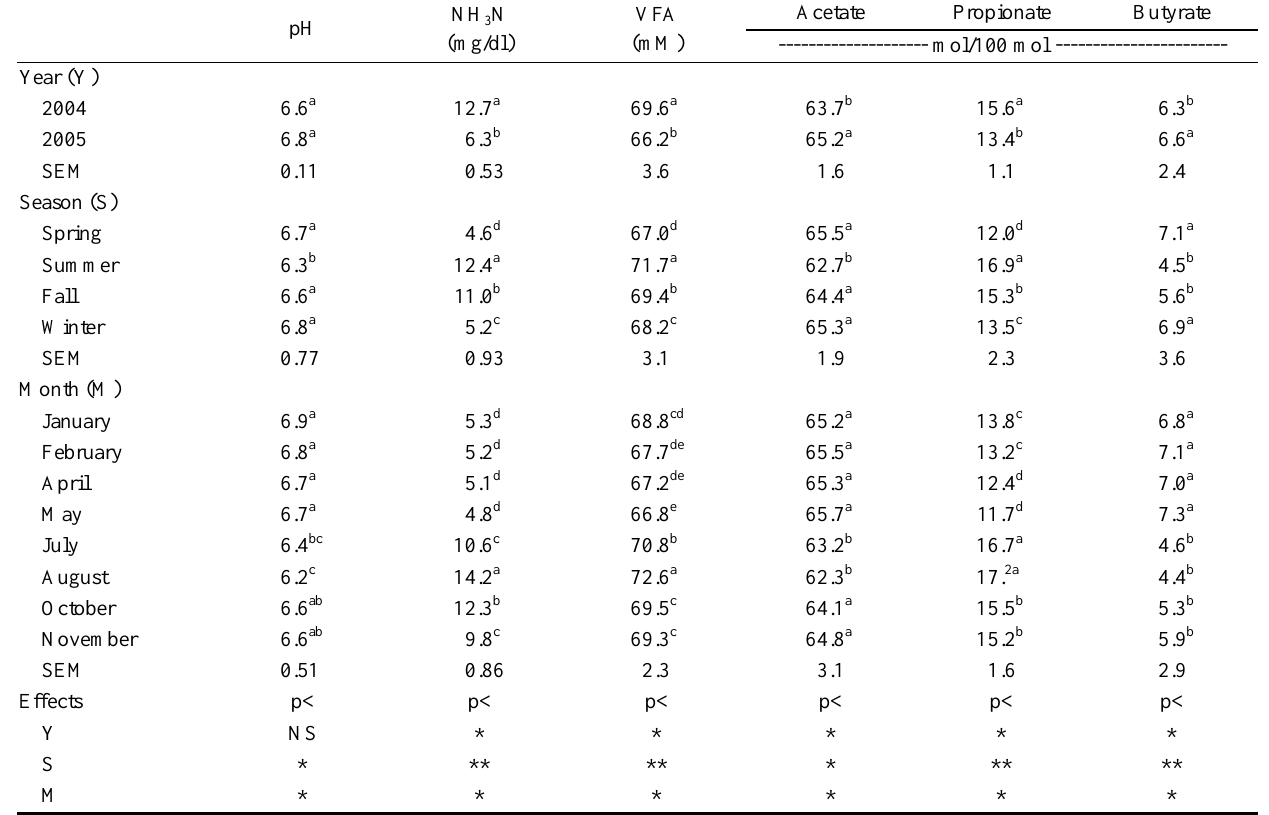
Table 4. Ruminal fermentation patterns of the diet consumed by grazing steers